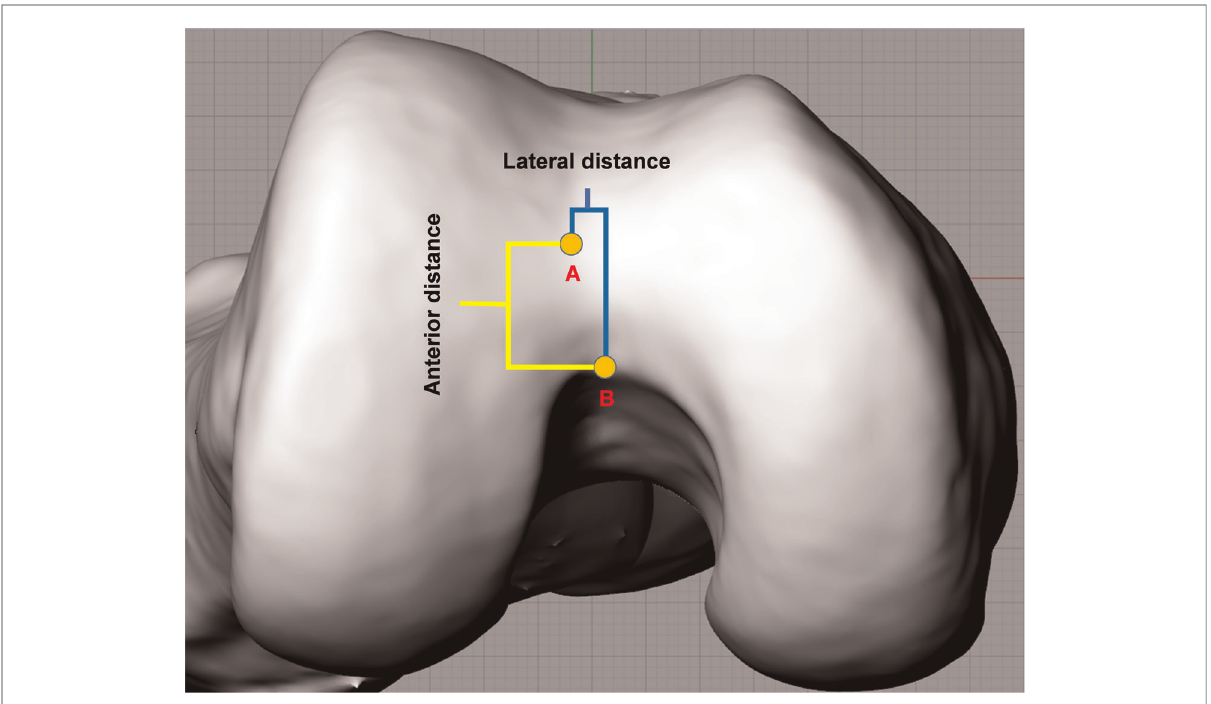
FIGURE 4 Measurement on axial plane. The anterior distance (highlighted by yellow line) represents the distance between the apex of the intercondylar notch (AIN) and entry point in the sagittal plane. The lateral distance (highlighted by blue line) represents the distance between the AIN and entry point in the coronal plane. Point A and B represent the AIN and entry point, respectively.